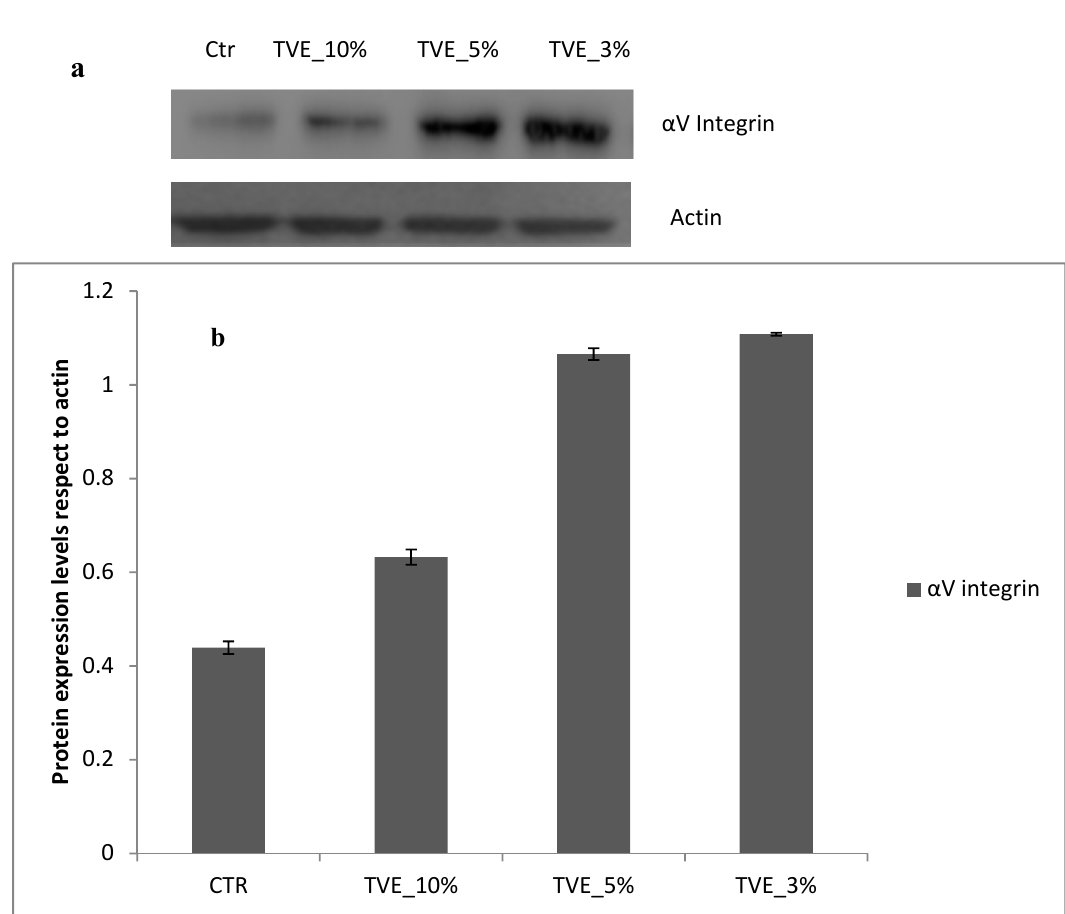
Figure 6. Western blot analysis. ( a ) Protein expression level of integrin α V. ( b ) Densitometric results were normalized in respect to actin. All values are expressed in the form of mean ± SD (n = 3 ).